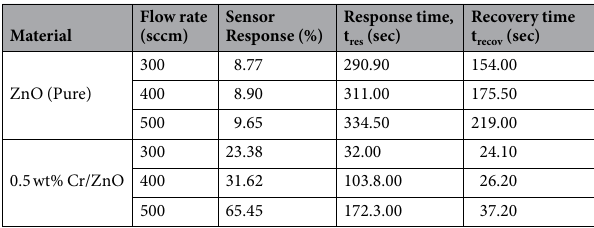
Table 4. Values of sensor response (sensitivity %), response time, and recovery time vs CO